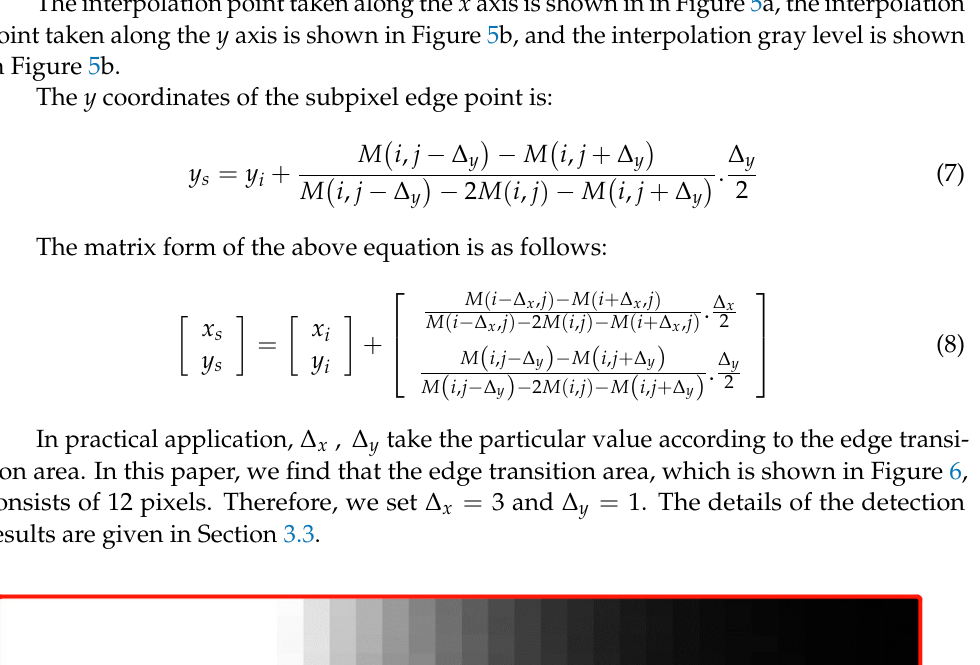
Figure 6. The edge transition area.